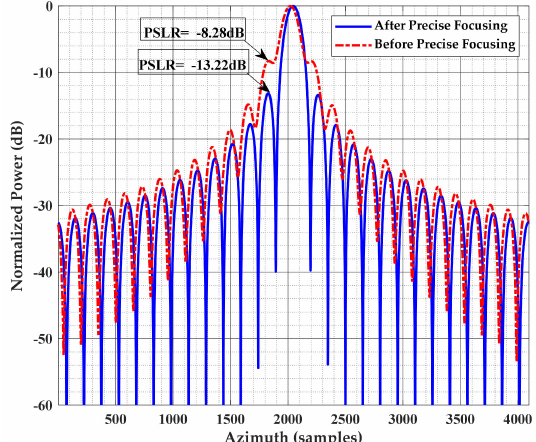
Figure 15. Imaging results before and after the precise focusing by hybrid correlation with kernel gate